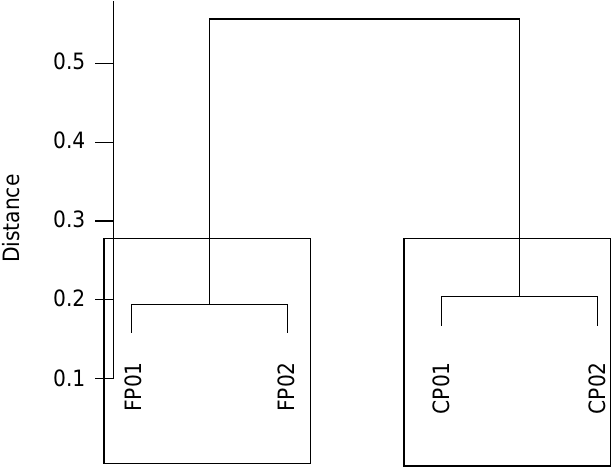
Figure 1. Dendrogram with the clustering of the plots of the Brazil nut stands Cachoeira and Filipinas related to fruit production and number of individuals. CP01 and CP02: Cachoeira; FP01 and FP02: